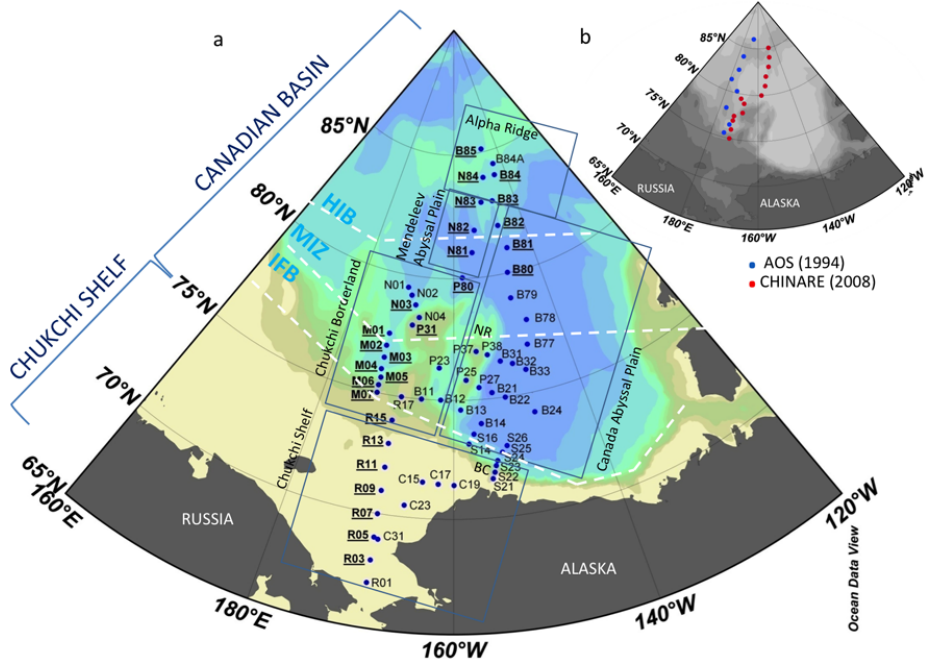
Fig. 1. (a) Sampling stations during the R/V CHINARE 2008 cruise performed onboard the R/V XueLong icebreaker (1 August–8 Septem- ber 2008). Blue dots indicate stations where pigments were measured. Bold and underlined stations numbers indicate the stations where taxonomy data are available. The study area covered the shallow Chukchi shelf ( < 100m) and the deep Canadian basin (100 to 4000m). The Canadian basin included the Canada Abyssal Plain, the Alpha Ridge, the Mendeleev Abyssal Plain and the Chukchi Borderland. The Barrow Canyon (BC) and the Northwind Ridge (NR) are indicated. Three areas are distinguished over the basin based on ice concentrations: the ice-free basins IFB (ice < 20%), the marginal ice zone MIZ (20% < ice < 70%) and the heavy-ice basin HIB (ice < 70%). (b) Location of the stations sampled in 1994 (blue) and 2008 (red) used for comparison, discussed in the Sect.